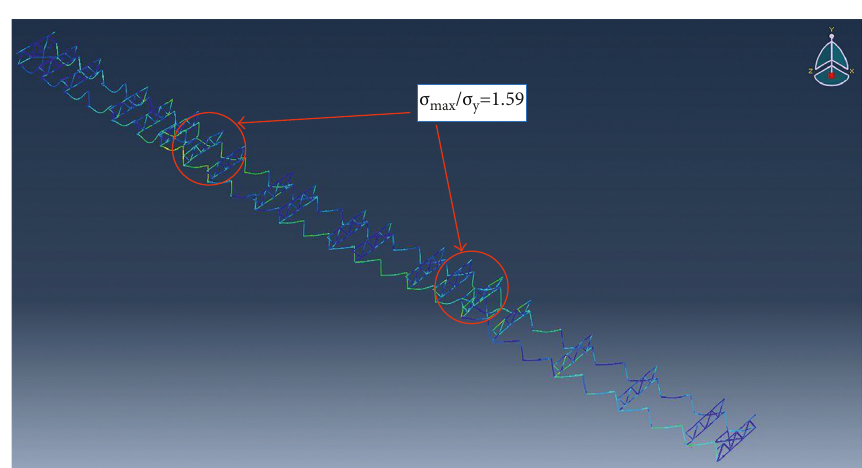
Figure 29: Members with the maximum σ / σ